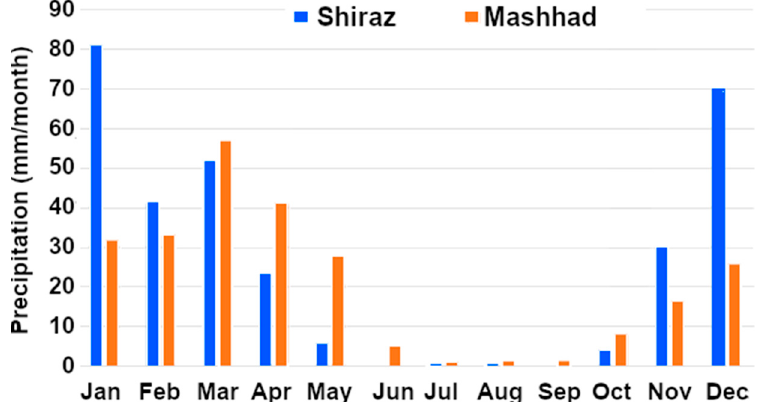
Figure 2. Monthly precipitation variations in Mashhad and Shiraz boxes based on 1981–2014 data derived from Iran Meteorological Organization.